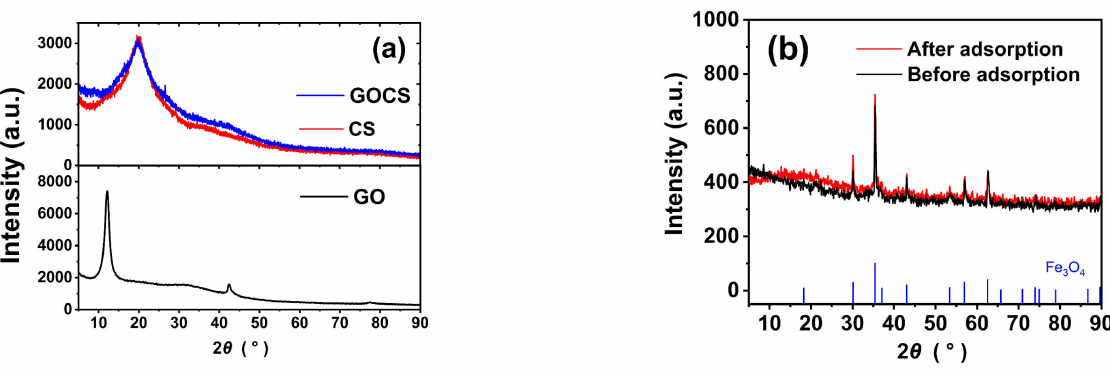
Figure 2. ( a ) XRD patterns of GO, CS, and GOCS; ( b ) MGOCS before and after adsorption of As(III).